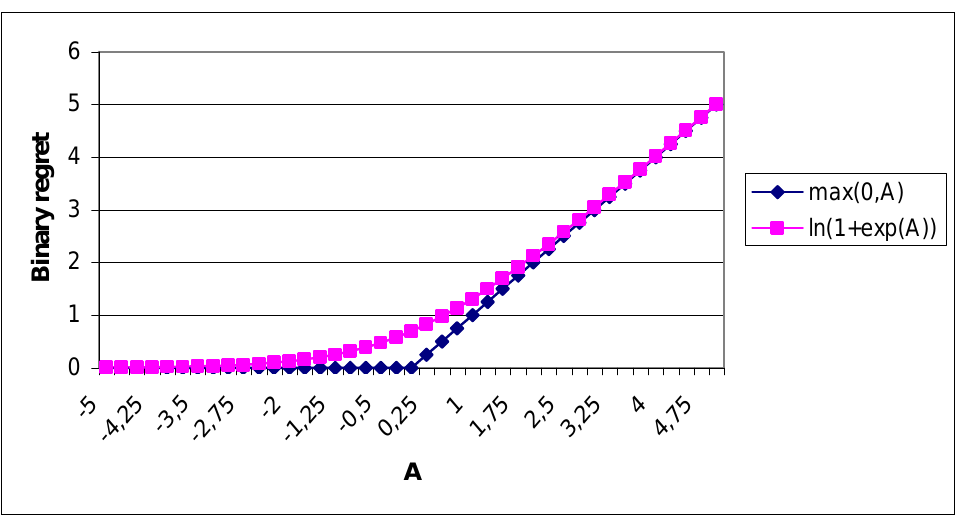
Figure 1. Using the Logsum to smoothen binary regret Systematic